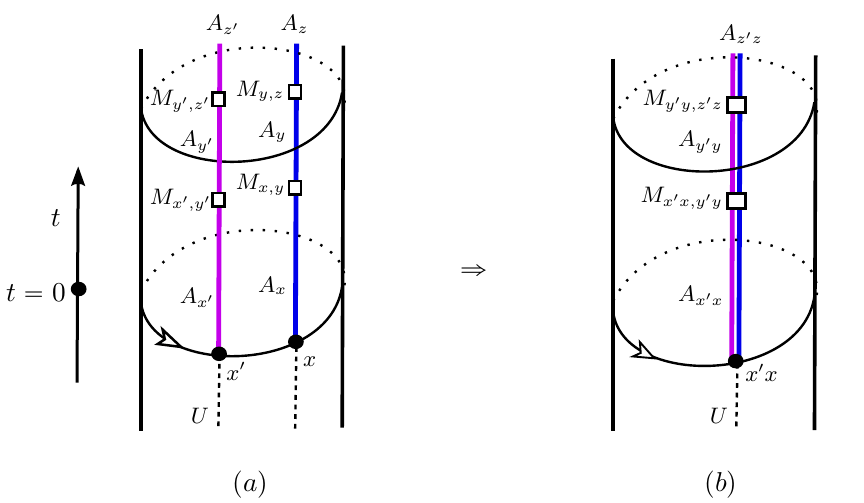
Figure 7 . This picture depicts how to fuse spatially or horizontally two topological edge excitations x and x 1 , together with boundary CFT’s A x , A y , A x 1 , A y 1 and walls M x;y , M x 1 ;y 1 . supported on x 1 b x to a new (cid:12)xed point theory, which is given by A non-trivial, then A A A . But we expect that the RG (cid:13)ow gives a x (cid:28) x 1 b U x 1 b x